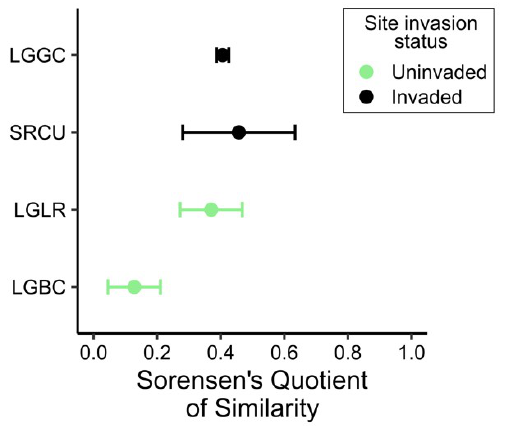
Figure 3. Sørensen’s quotient of similarity comparing standing vegetation and seed banks for L. hexapetala -invaded and uninvaded marshes in the Laguna de Santa Rosa. Sørensen’s quotient = 1 indicates complete similarity. Site and species codes are defined in Figure 1. Data points represent means with 95% confidence interval bars.